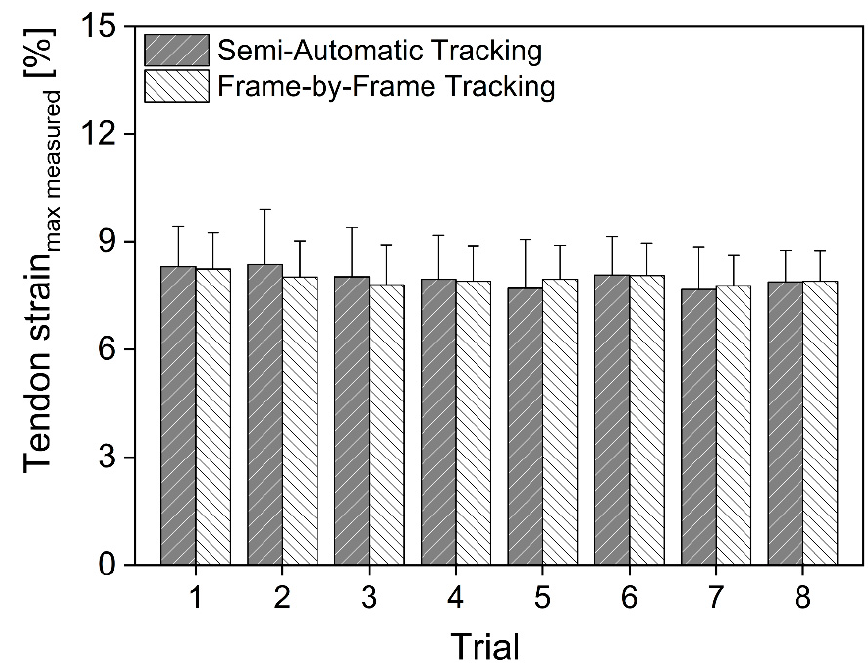
Figure 2. Means and SD of the measured maximal Achilles tendon strain (i.e., without correcting for tendon strain caused by the inevitable ankle joint rotation) for the devised method (i.e., digitizing US images at rest and at maximal AT force) and for the manual frame-by-frame tracking procedure for all eight trials.